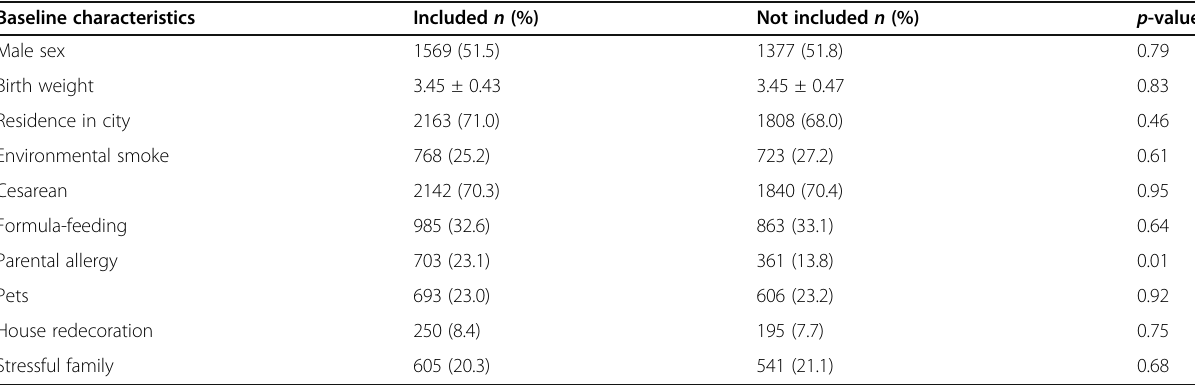
Table 1 Baseline characteristics of children included ( n =3047) and not included ( n = 2659) Baseline